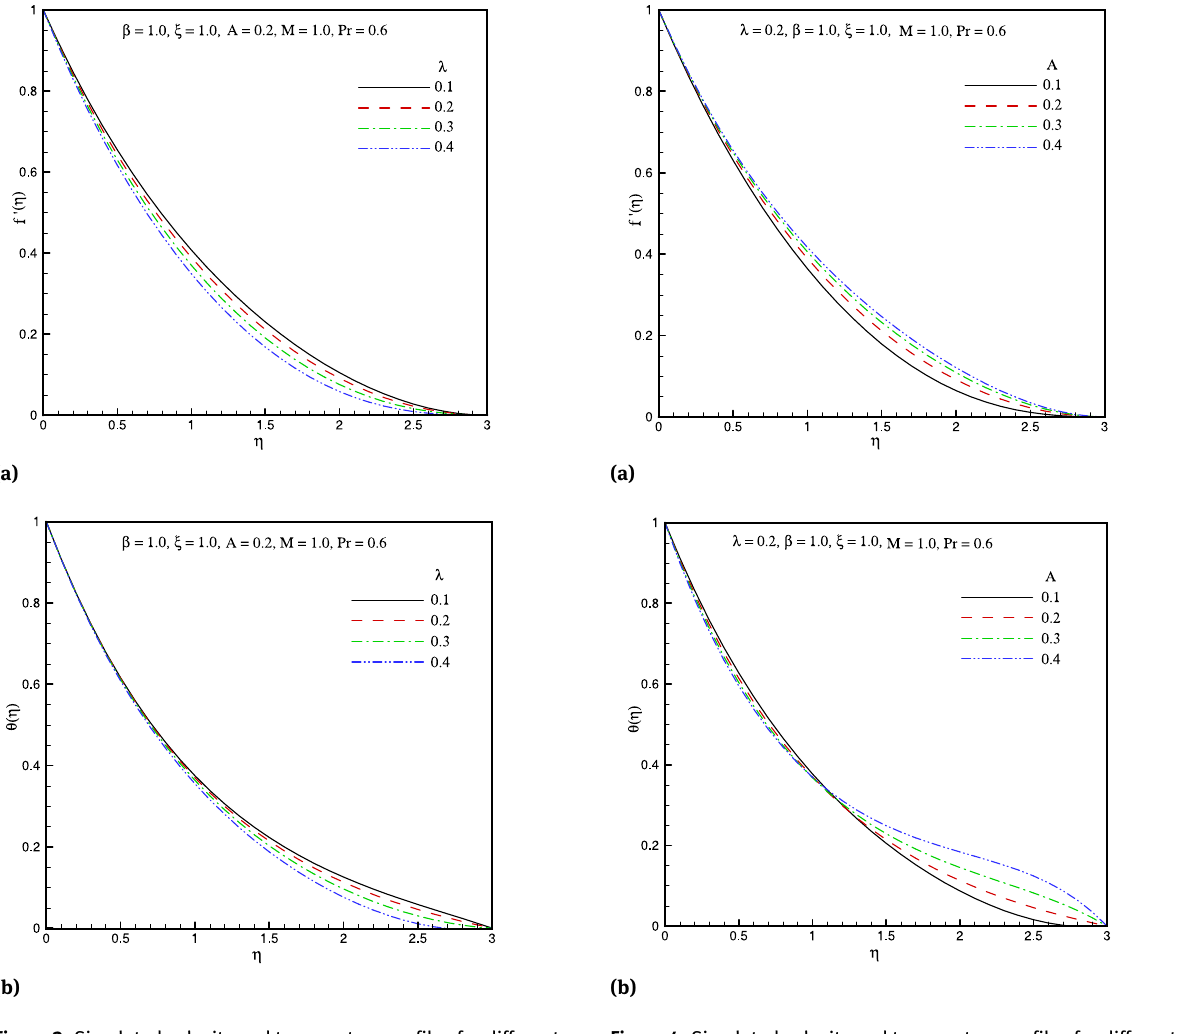
results in the decrease in fluid velocity. Also, boosting val- ues of ξ yields a marked decrease in temperatures of the fluid at the surface regime considerably and the thickness of the thermal boundary layer becomes trim down. Figures 6a and 6b represent the influence of Pr on simulated flow-field profiles. Figure 6a reveals that with higher Pr values (thermal conductivity reduces) the fluid flow is slow down, and the momentum boundary layer thickness is decreased. Correspondingly, the temperature profiles are lessened with augmenting Pr values as per- ceived in Figure 6b. Also, the temperature variation is much more important for lower values of Pr when com- pared with greater values. Fluid with lower values of Pr (< 1) signify liquid-like components, which possess higher thermal conductivities but low viscosity. On the other